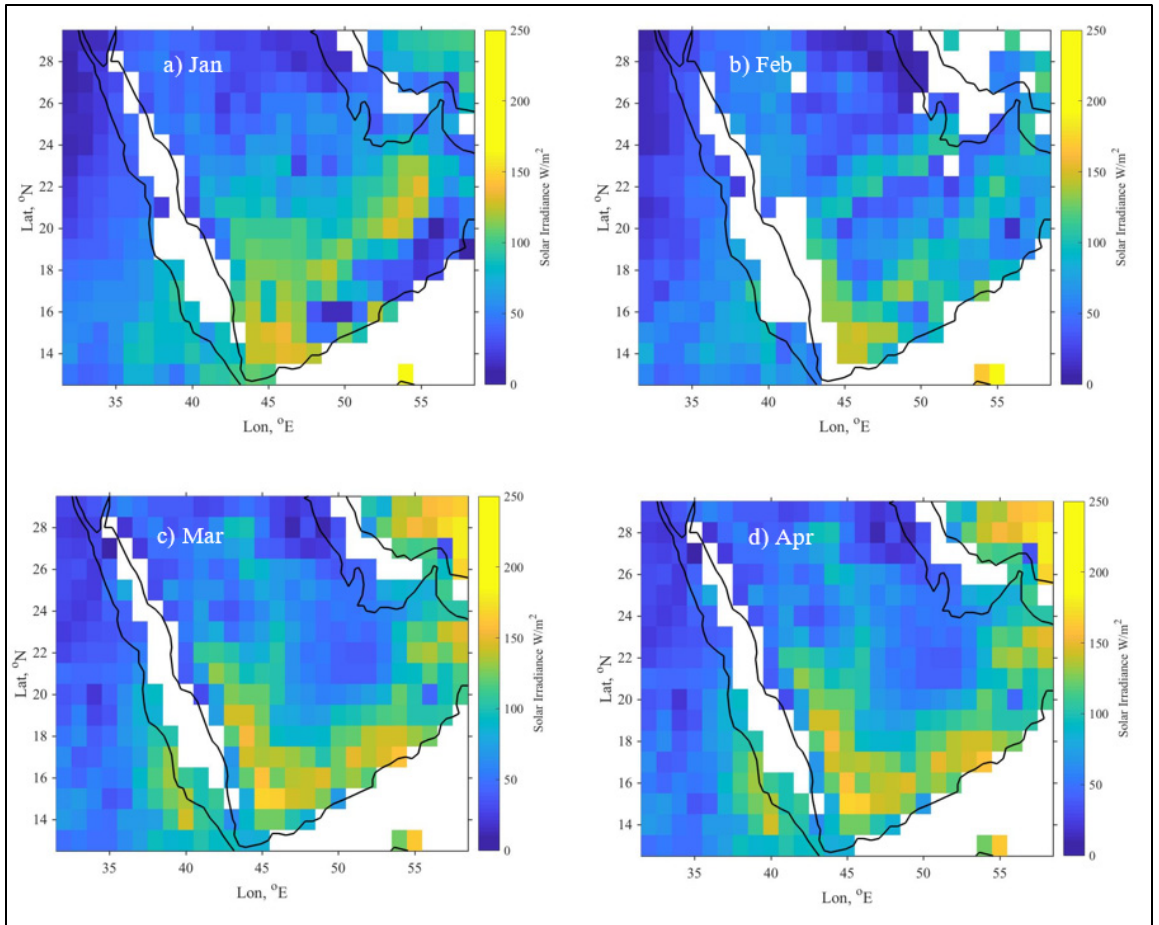
Figure 9. Intra-annual direct solar irradiance over AP during ( a – d ) January–April 2017, respectively.